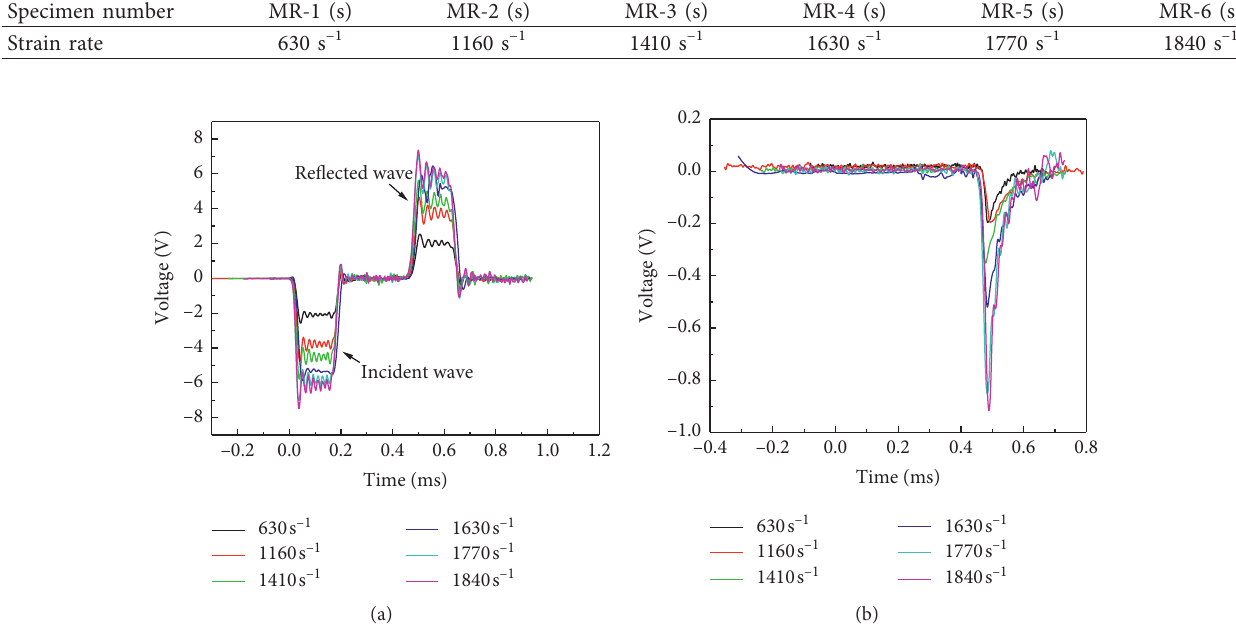
Table 2: Strain rate of the samples.